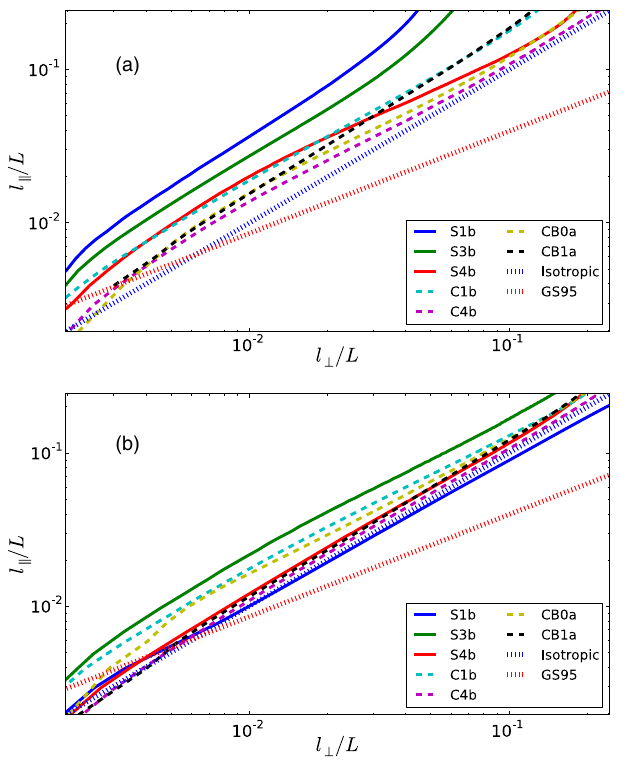
FIG. 13. The variation of l k versus l ⊥ for the fast modes for the (a) magnetic field and (b) velocity field. The blue dotted line shows isotropic behavior, while the red dotted line shows the Goldreich-Sridhar scaling.